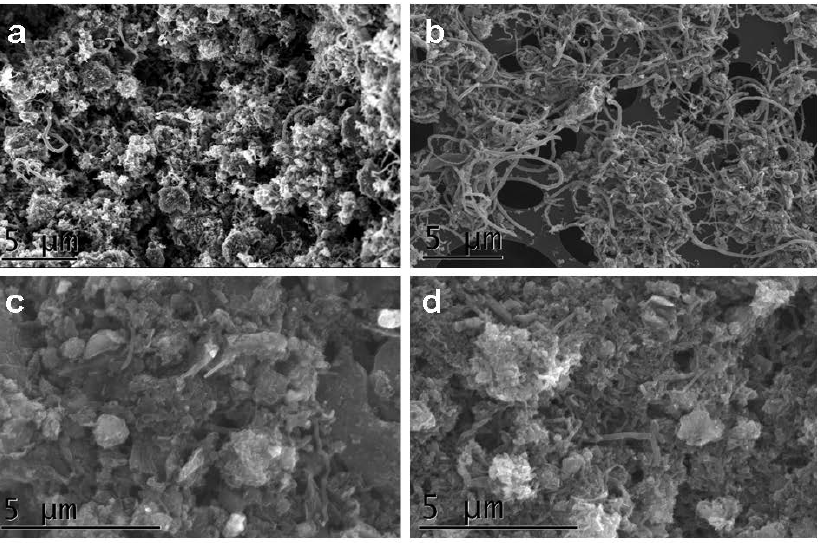
Figure 1. Typical scanning electron microscope (SEM) SE images of the CNF